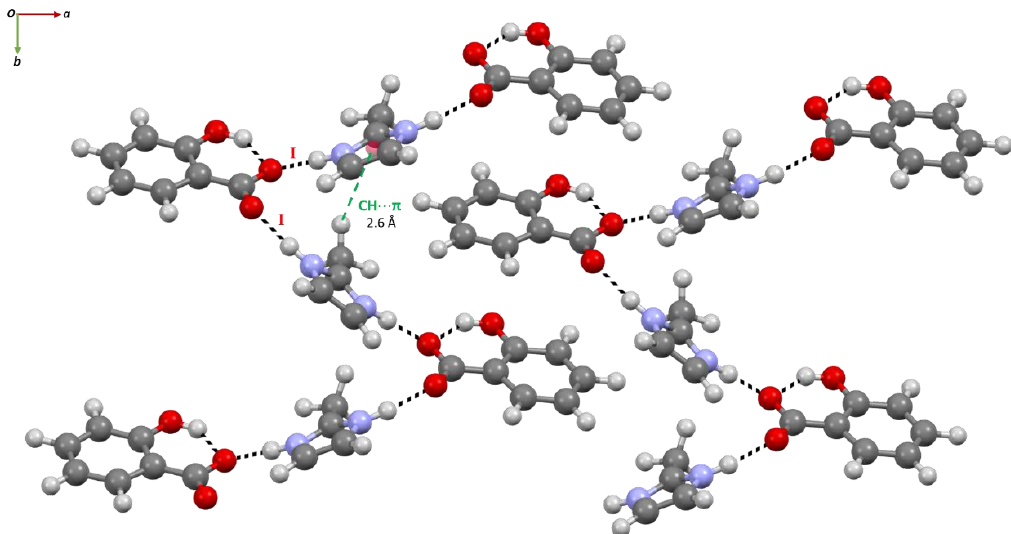
Figure 7. Zig - zag packing arrangement of alternated SA / 2-MEIM molecules, along b , evidencing the + N-H (2-MEIM) ⋯ O −(SA) and C-H (2-MEIM) ⋯ π (2-MEIM) HB interactions.